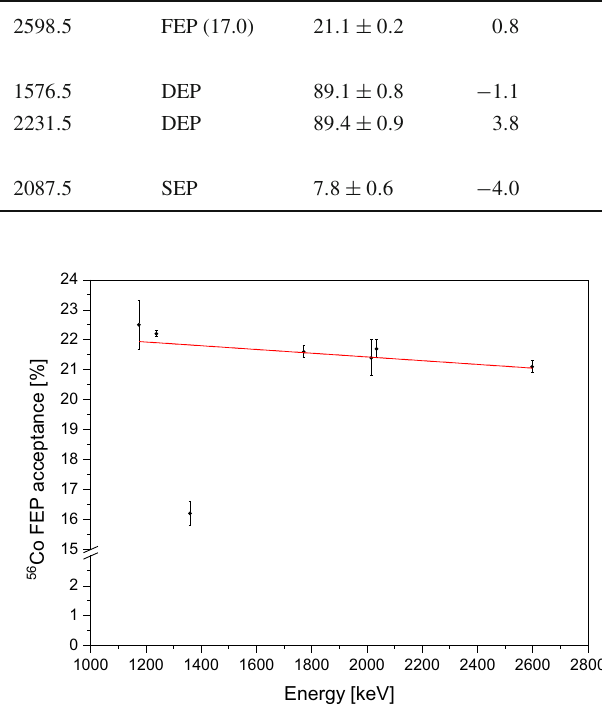
Fig. 19 Acceptance of the FEP events as a function of energy for the simulated 56 Co spectrum